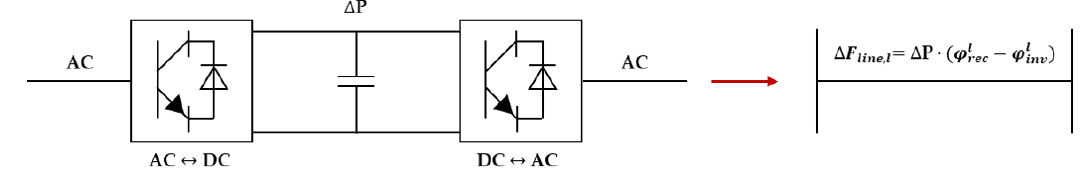
Figure 3. Power flow change caused by back-to-back (BTB) HVDC active power operation.